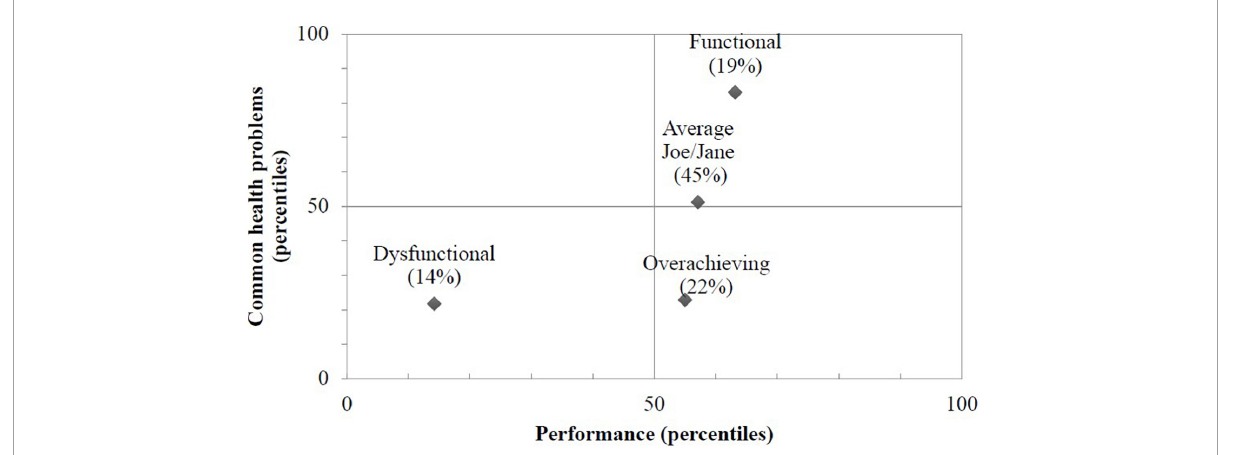
FIGURE2 Four latent profiles of presenteeism according to performance level and common health problems.